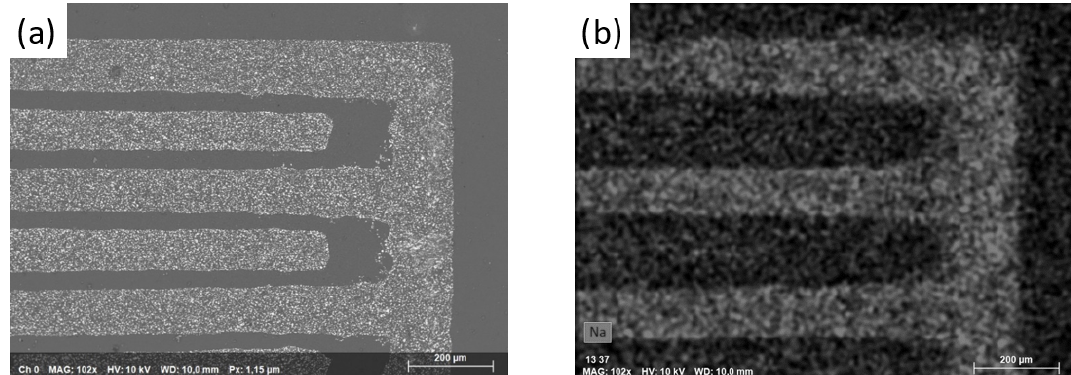
Figure 8. (a) SEM image showing a selected section of the IDE. (b) Sodium EDX signal in the same section shows the irregular distribution of sodium after a multiple sensor